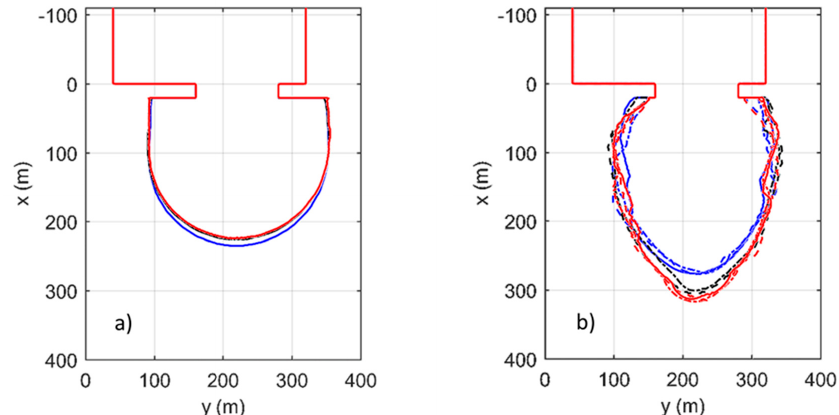
Figure 14. The stoppage boundary profiles of FGT66 for grid resolution analysis. ( a ) Bingham model (BM); ( b ) modified bi-viscosity model (MBM). Red lines: dz = 0.8; black lines: dz = 1.0; blue lines: dz = 1.2; solid lines: dx = dy = 1.8; dashed lines: dx = dy = 2.0; dash – dot lines: dx = dy = 2.2.